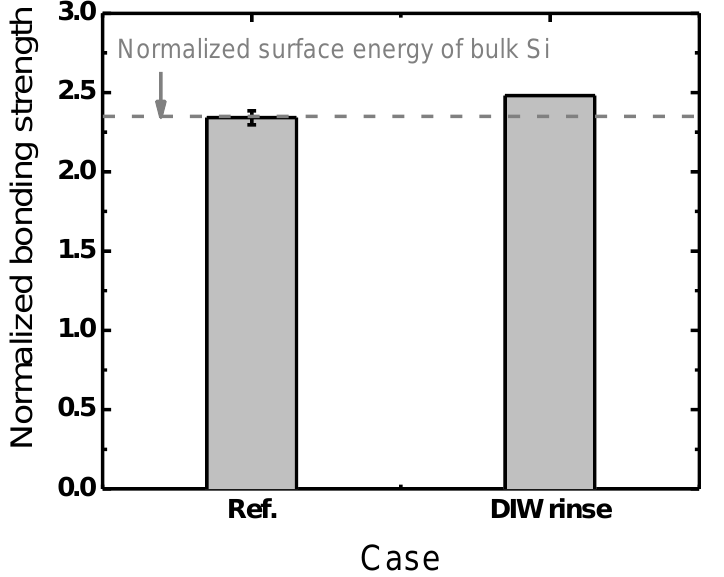
Figure 4. Comparison between the bonding strengths from Si wafers DIW cleaned before and after plasma treatment normalized to the bonding strength with no plasma treatment.